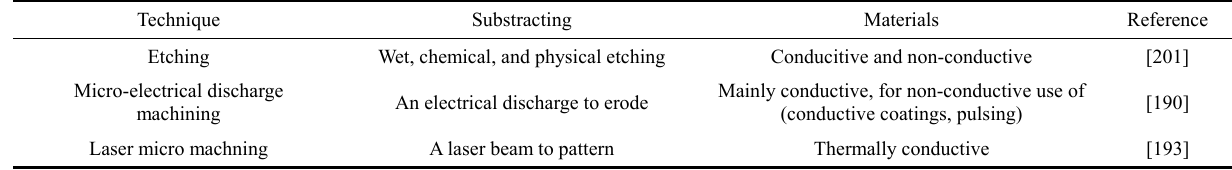
Fig. 29 Optical micro-graphs of holes fabricated using (i) different laser power and (ii) different durations. The first row is the entrance hole while the second row is the exit hole. Reproduced with permission from Ref. [200], © Elsevier B.V. 2008. Table 4 Summary of subtracting techniques used for MEMS